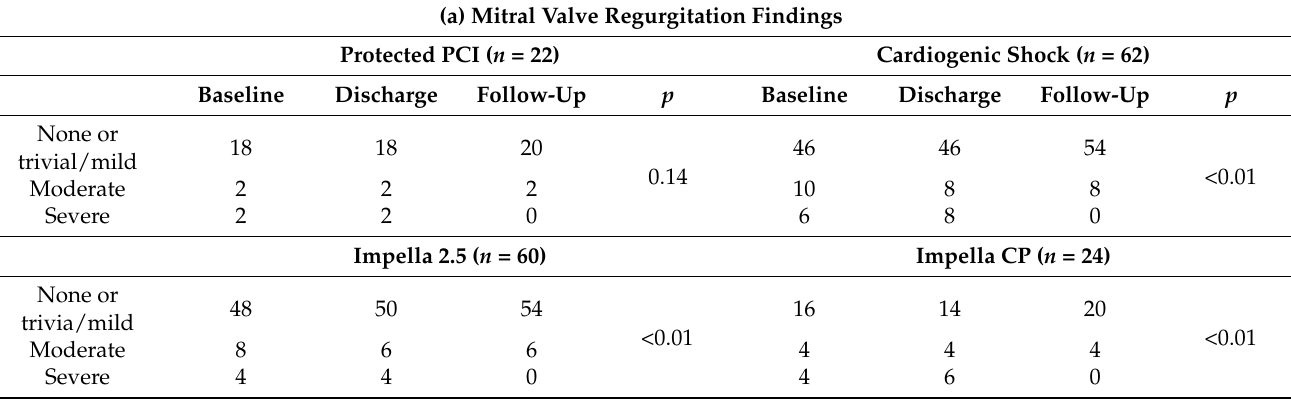
Table 2. Mitral valve